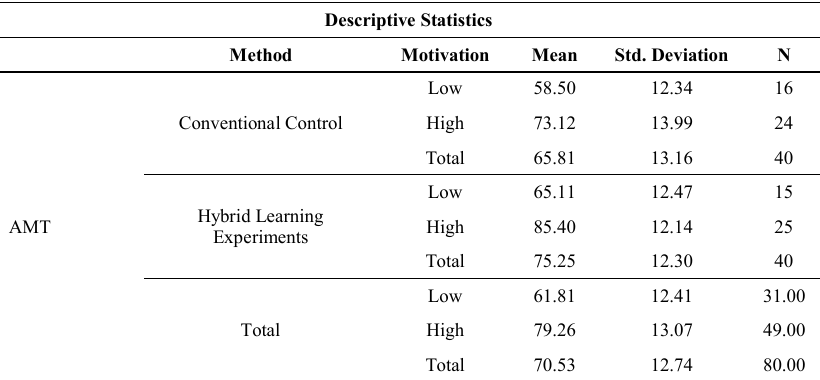
Table 5. Dimensions and Indicators of learning